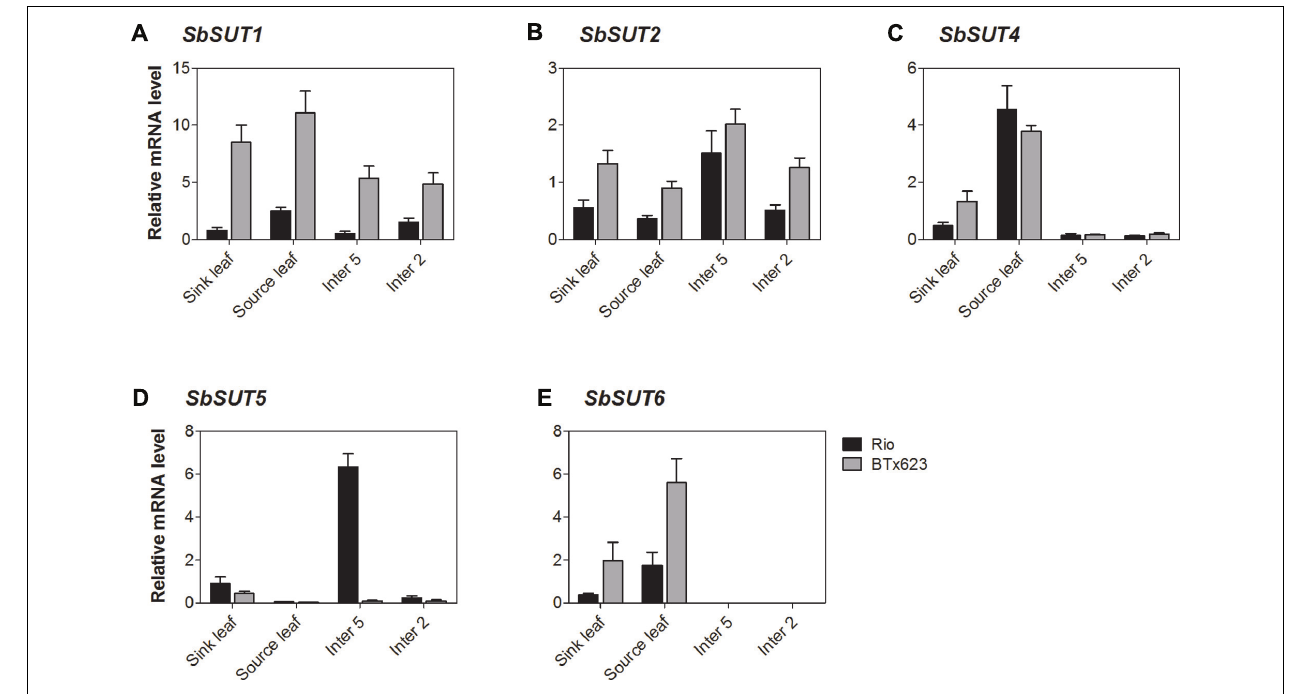
FIGURE 5 | Sorghum SUT transcript levels during vegetative growth. Relative expression during vegetative growth of Sorghum SUTs.